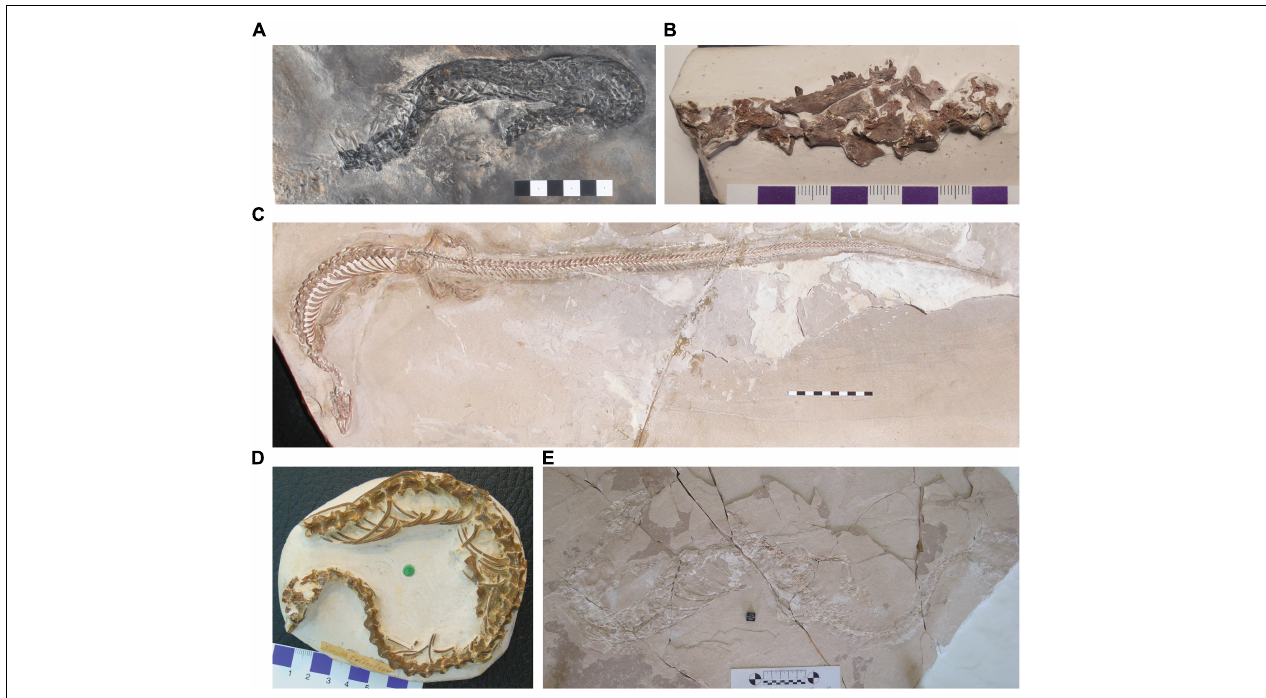
FIGURE 1 | A selection of dolichosaur fossils. (A) Adriosaurus skrbinensis (SMNH 2158); (B) Conisasaurus crassidens (BMB 007155); (C) Pontosaurus kornhuberi (MSNM V3662); (D) Dolichosaurus longicollis (BMNH R 49002); (E) Primitivus manduriensis (MPUR NS 161).